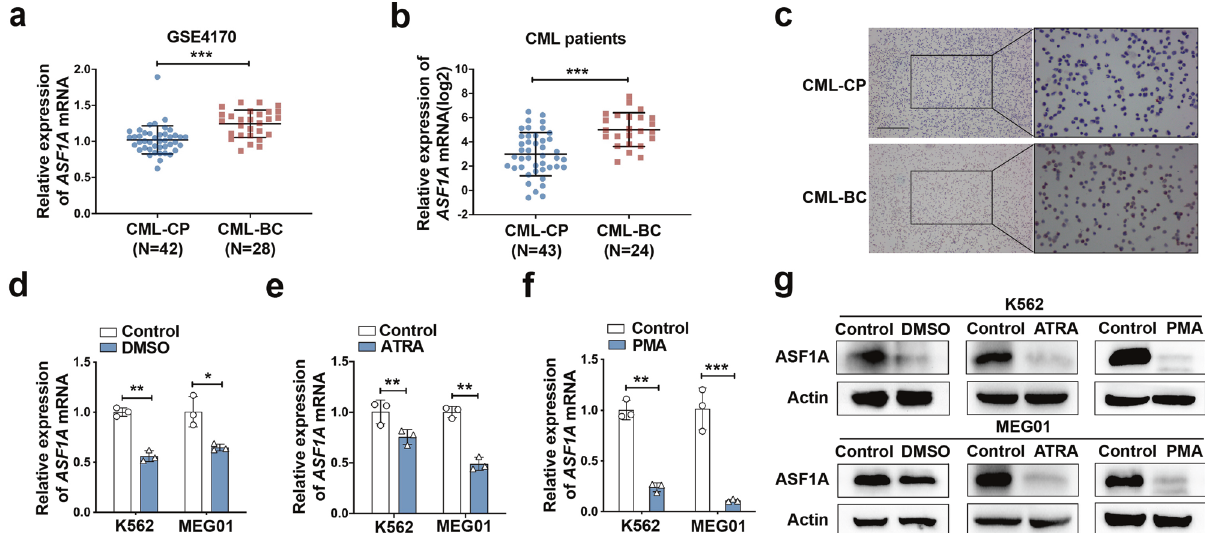
Fig. 1 ASF1A was upregulated in CML-BC patients and involved in cell differentiation. a Relative expression of ASF1A mRNA in CML-CP and CML-BP patients using the GEO database (GSE4170). b qRT-PCR analysis of ASF1A mRNA levels in CML-CP and CML-BP patients. c ICC analysis of ASF1A protein levels. Scale bar, 200 μ m. d – f qRT-PCR analysis of ASF1A mRNA levels in K562 and MEG01 cells pretreated with solvent (control) or DMSO/ATRA/PMA. g Western blot analysis of ASF1A in K562 and MEG01 cells pretreated with solvent (control) or DMSO/ATRA/ PMA. Statistical signi fi cance was determined by Student ’ s t -test. Data are shown as mean ± standard deviation (SD). Data are shown as a representative result with three repeats from three independent experiments. The cell lines are applied with three independent lentiviral infections in d – g . * P < 0.05, ** P < 0.01, *** P <